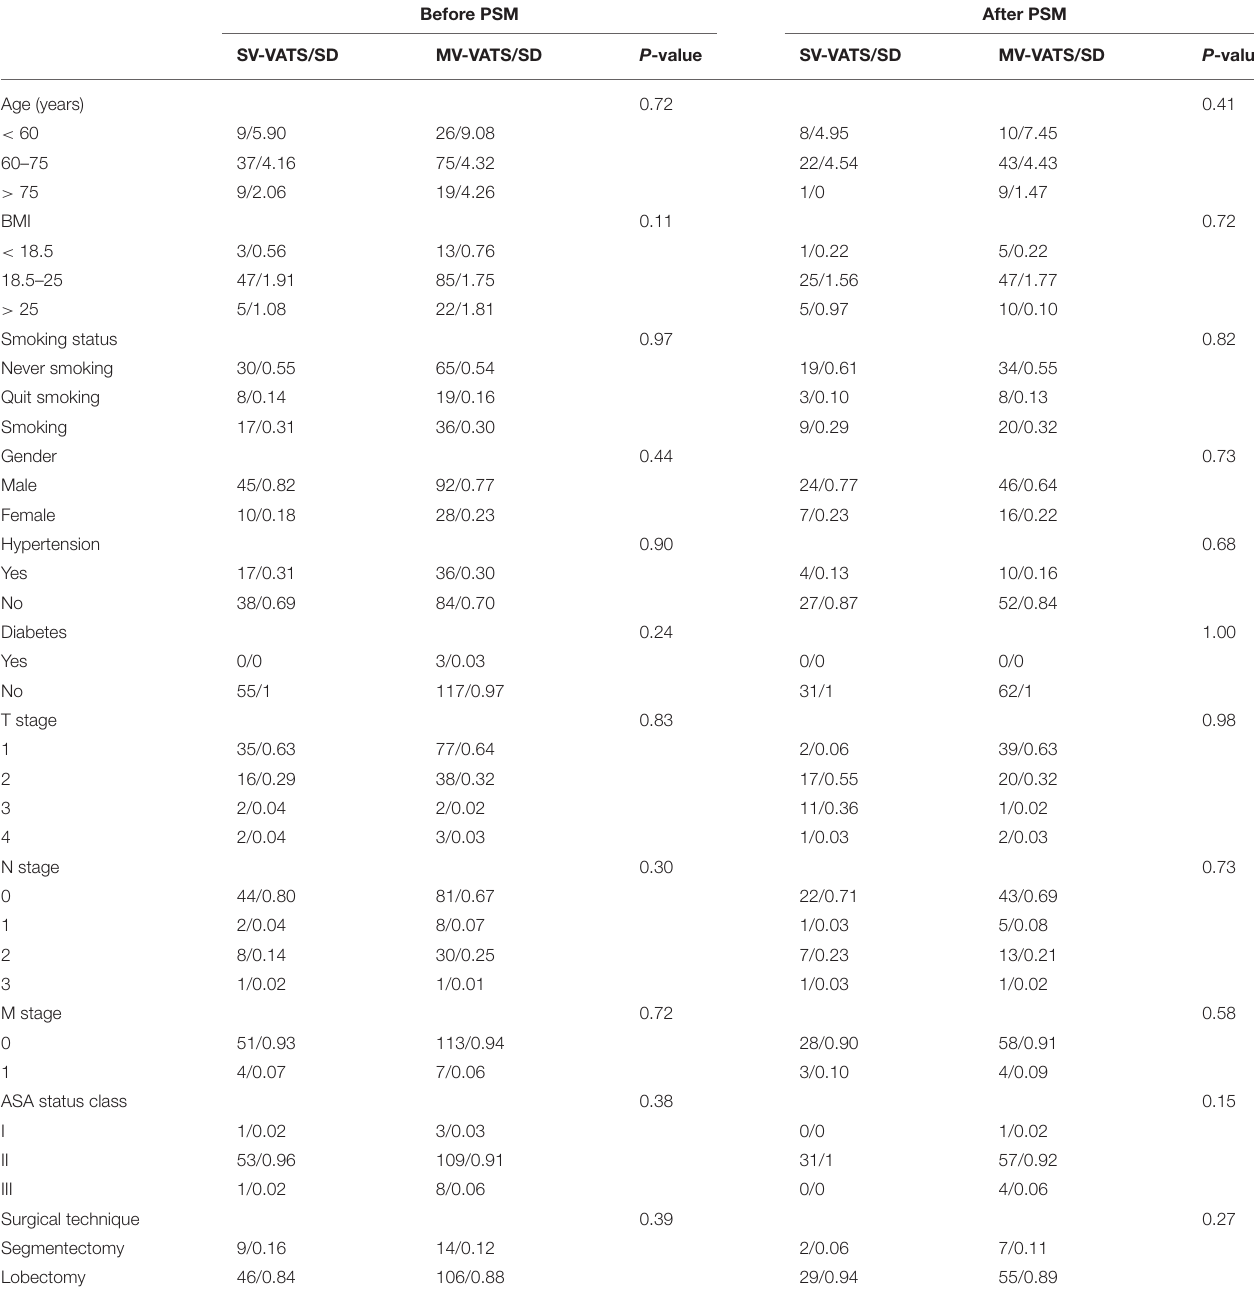
TABLE 1 | Distribution of preoperative confounders among patients with worse lung function (defined as FEV1/FVC < 70%) in the SV-VATS and MV-VATS